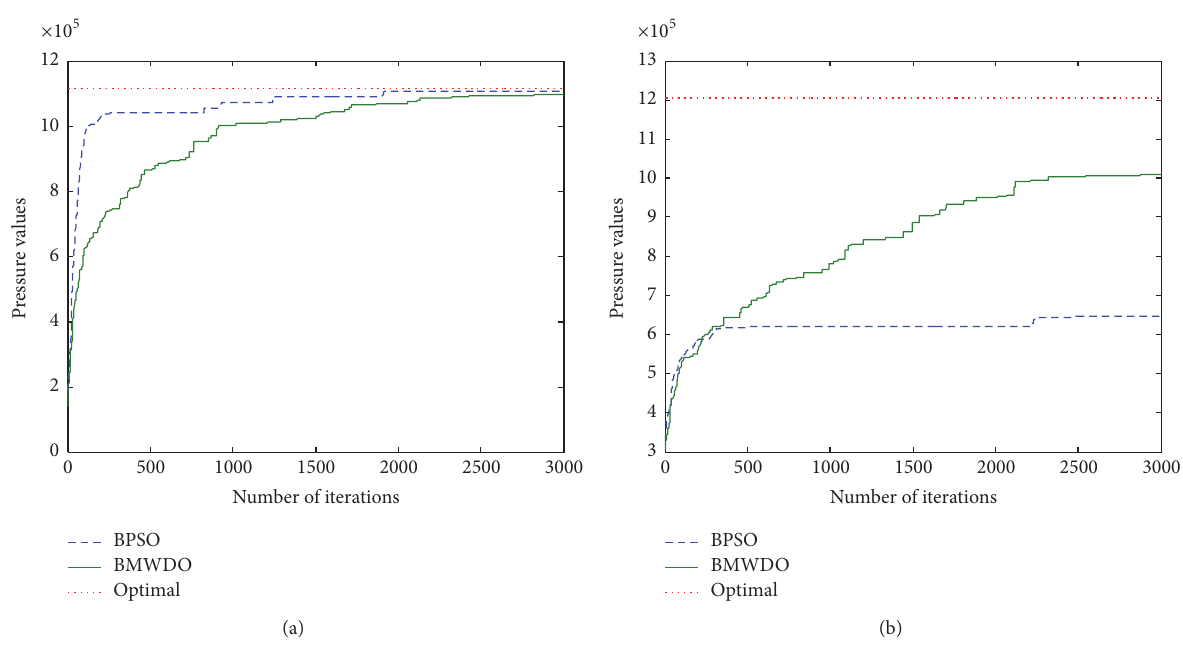
Figure 4: Average convergence graphs of BPSO and BMWDO with 20 runs under different SNR (before pulse compression). (a) SNR = − 10dB. (b) SNR = − 28